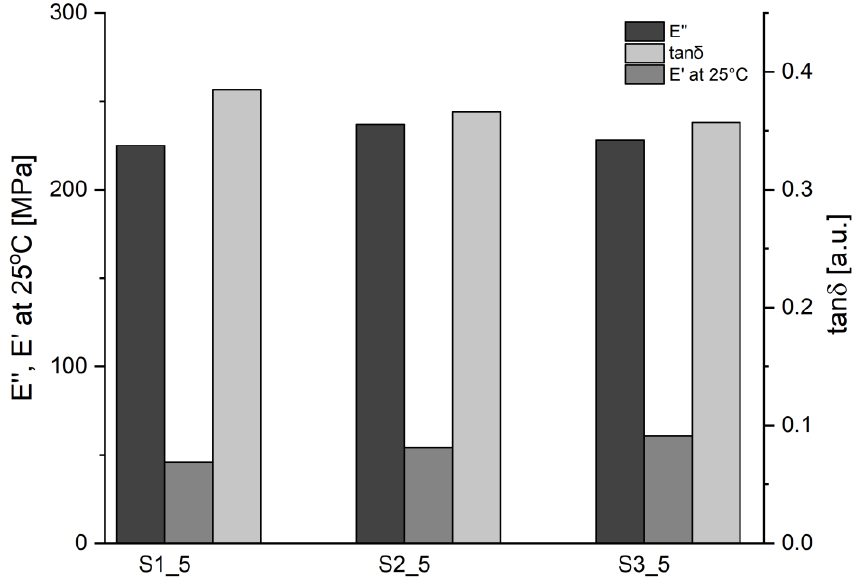
Figure 7. Comparison of such E”, E’ at 25 ◦ C and tan δ for bio-TPU–ABW composites containing 5 wt.% of the ABW fillers. Table 3. Tensile strength ( TS b ), elongation at break ( ε Break ) and hardness determined for bio-TPU matrices and bio-TPU–ABW composites.